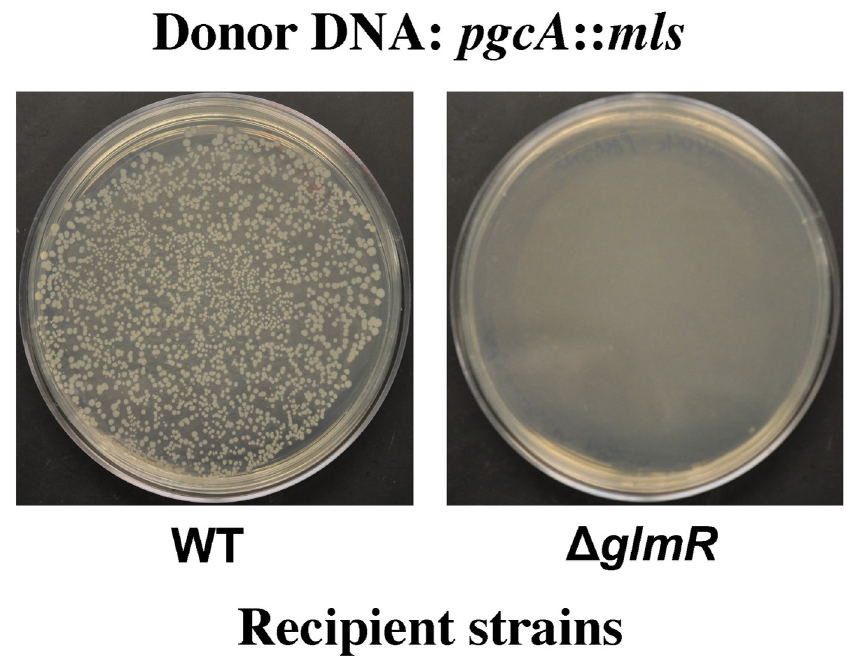
Fig 2. glmR and pgcA mutations are synthetic lethal. Recipient strains WT and Δ glmR were transformed with pgcA : mls chromosomal DNA and the transformants were selected on LB plate with MLS antibiotics and 20 mM MgSO 4 . Pictures of the transformation plates were taken after overnight incubation at 37 0 C.